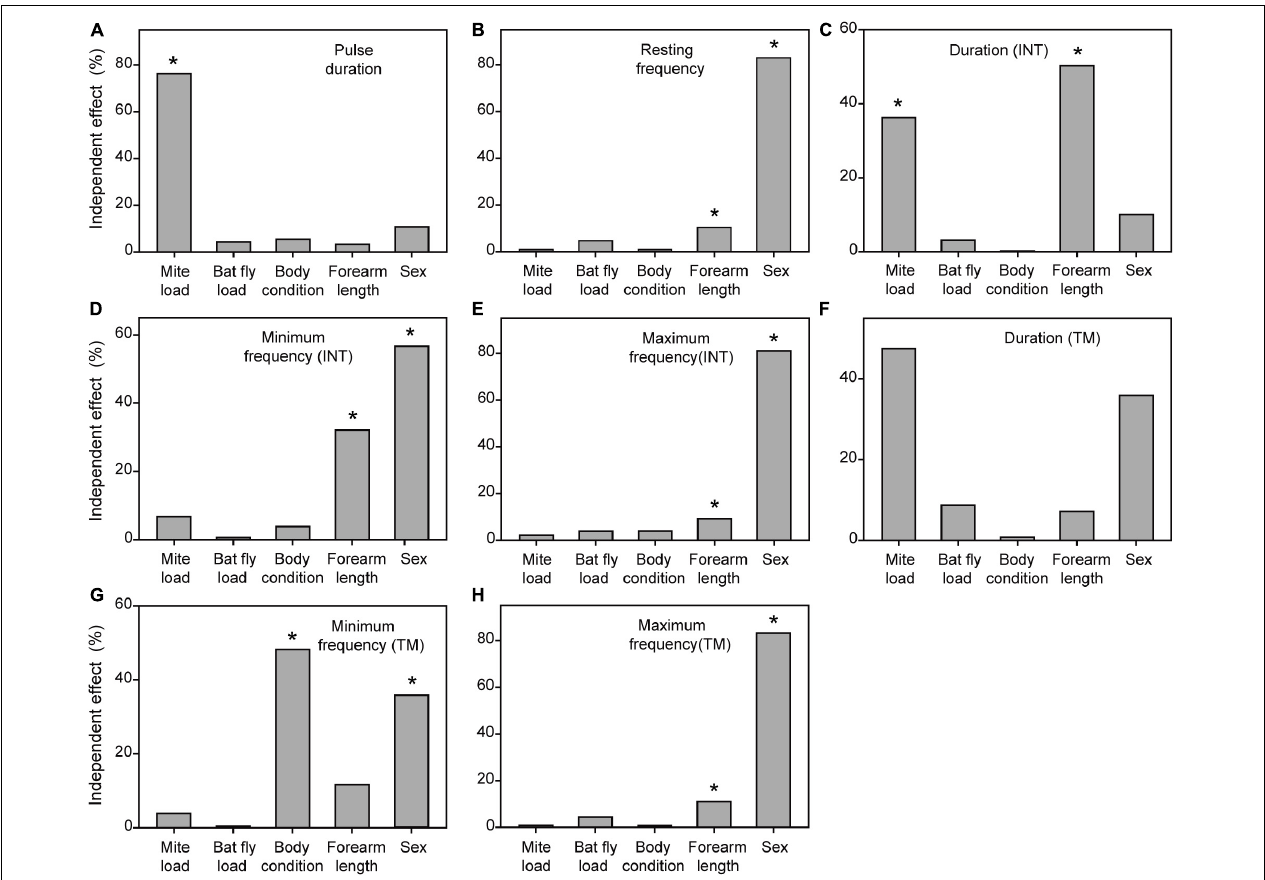
FIGURE 4 | Independent contributions (%) of the five explanatory variables to the inter-individual variation in pulse duration (A) , resting frequency (B) , duration (INT) (C) , minimum frequency (INT) (D) , maximum frequency (INT) (E) , duration (TM) (F) , minimum frequency (TM) (G) , and maximum frequency (H) of echolocation pulses, calculated with hierarchical partitioning. Asterisks denote statistical significance (* P < 0.05). INT, initial frequency modulated component. TM, terminal frequency modulated